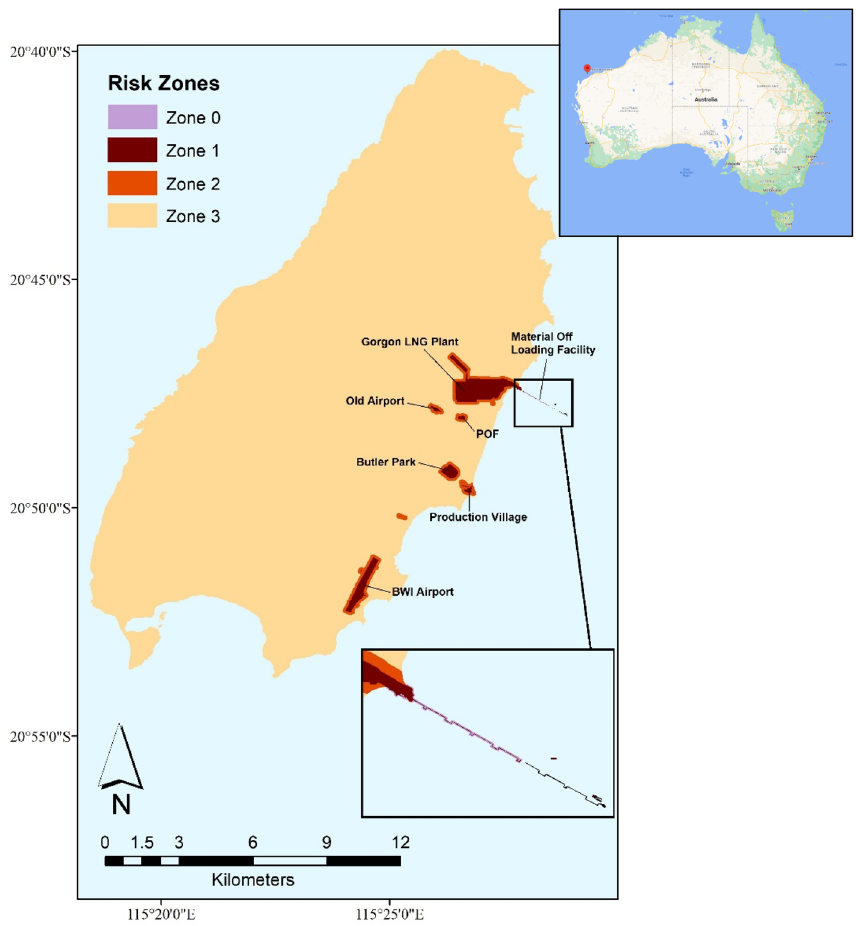
Figure 1. Quarantine invasion risk map of the Asian house gecko (AHG) on Barrow Island 12 . Inset map at the top right is the map of Australia with the location of Barrow Island shown as a red marker (https:// www. google. com/ maps). Zone 0 is the buffer area at Material Offloading Facility (MOF) (i.e. X-Blocs area). Zone 1 is the area with the highest occupancy probability, where the majority of the surveillance budget should be spent. Zone 2 is the secondary introduction area (100 m buffer area around Zone 1) and is considered the lower risk boundary for a species dispersing out of Zone 1. Zone 3 is the remaining island area where the AHG is less likely to establish prior to detection thus with no SSCs